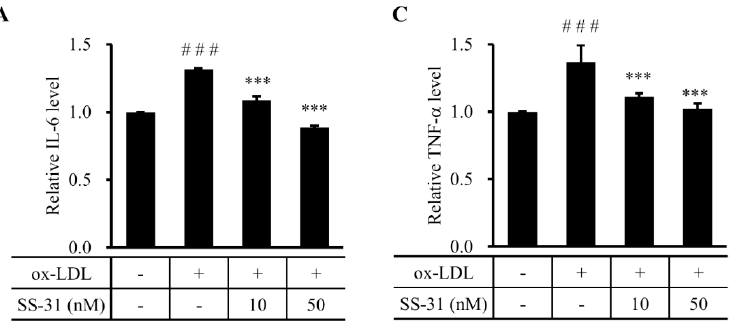
Figure 4. Cont. Figure 4.